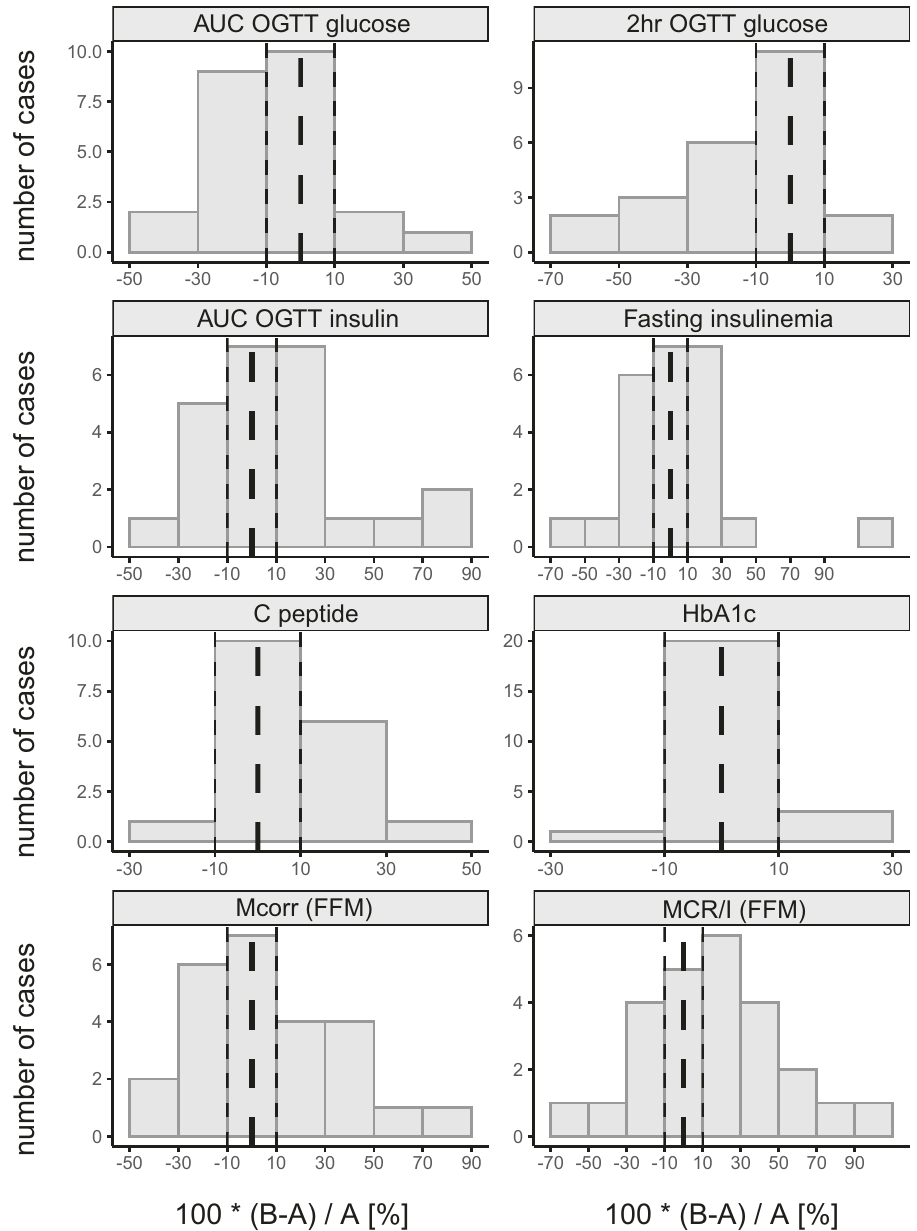
Fig. 6 Effect of inulin supplementation on selected markers of glucose metabolism. Data are expressed as the percentual change baseline to post-intervention. A, time point prior to intervention; B, time point post-intervention. Dashed line, 0%; dotted lines, ±10% before and after the intervention. In serum, the concentration of butyric acid, propionic acid, and asparagine increased signi fi cantly, whereas the concentration of glycerol and 2-propanol decreased after inulin treatment (Fig. S15 and Table S8). In feces, three VOCs were signi fi cantly different in abundance ( p ˂ 0.05) before and after inulin treatment, including two propionic acid esters (increased) and 1-hexanol (decreased) (Table S9). However, the signi fi cance disappeared after multiple comparisons. Prospective study: effect of inulin on glucose metabolism Inulin intake affected markers of glucose tolerance and insulin sensitivity, but the individual response was highly variable; we observed positive, no, or negative changes for each of the variables (Fig. 6 and Table S10). In the entire intervention group, we observed a signi fi cant improvement in glucose tolerance